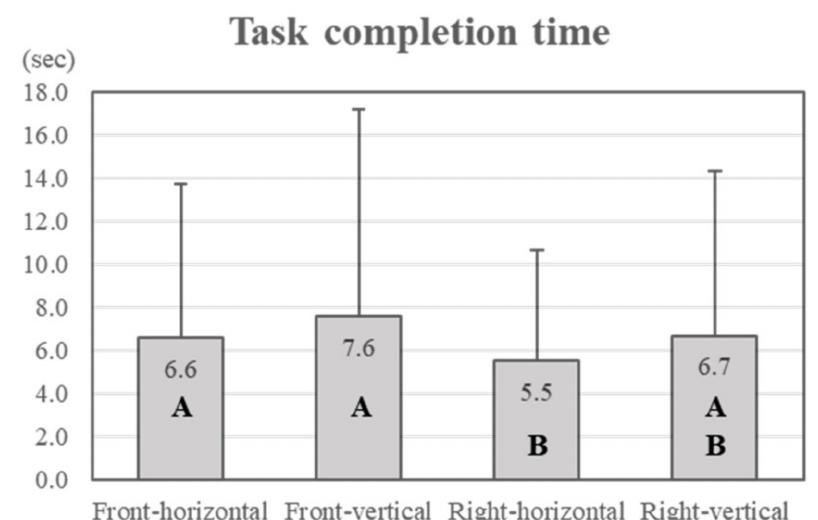
Figure 4. Task completion time (different letters in the bar graph indicate statistical differences).